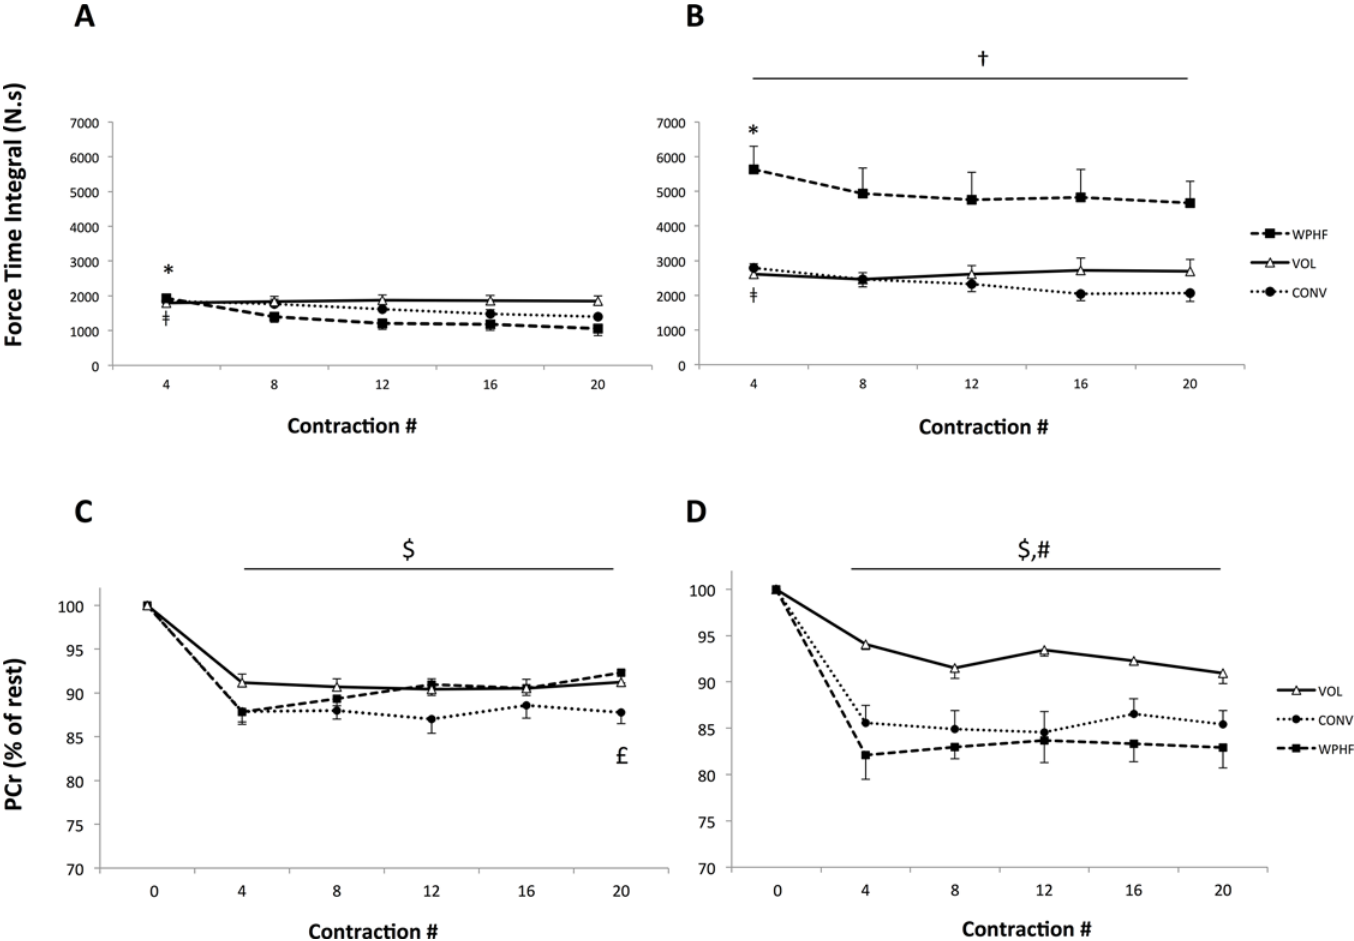
Fig 4. Force time integral and PCr concentrations expressed in percentage of the resting values (i.e., C0) for the non-responders (A & C) and responders (B & D) for each protocol calculated after contraction C4, C8, C12, C16, C20. * WPHF: C4 significantly different from C8, C12, C16, C20 (P < 0.05), ǂ CONV: C4 significantly different from C12, C16, C20 (P < 0.05), † WPHF for all contractions significantly different from all other exercise modalities illustrated (irrespective of group; P < 0.05). $ Significantly different than C0 for VOL, CONV and WPHF NMES for all contractions (P < 0.05), # Values for VOL for all contractions significantly higher than CONV and WPHF NMES (P < 0.05), £ C20 for CONV significantly lower than C20 for both VOL and WPHF (P < 0.05). Results are presented as means ±